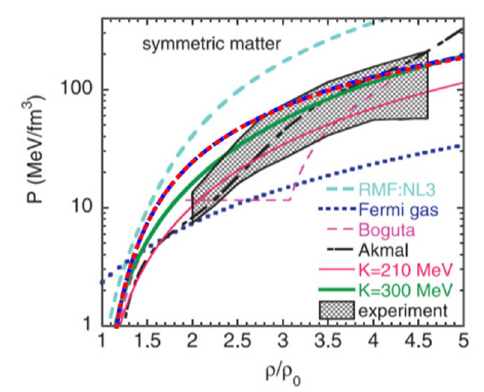
Figure 6 . The comparison between our quarkyonic matter model results with those from experi- mental constraints (shadow region) and other model predictions (colored lines) for the pressure P of symmetric nuclear matter as a function of baryon density. Note that this plot is made via adapting an original (cid:12)gure extracted from Re. [35], for which we keep the original notations of the various physical quantities. In particular, the baryon density (cid:26) ( (cid:26) 0 ) in this plot corresponds to n B ( n 0 ) we use in other places of the